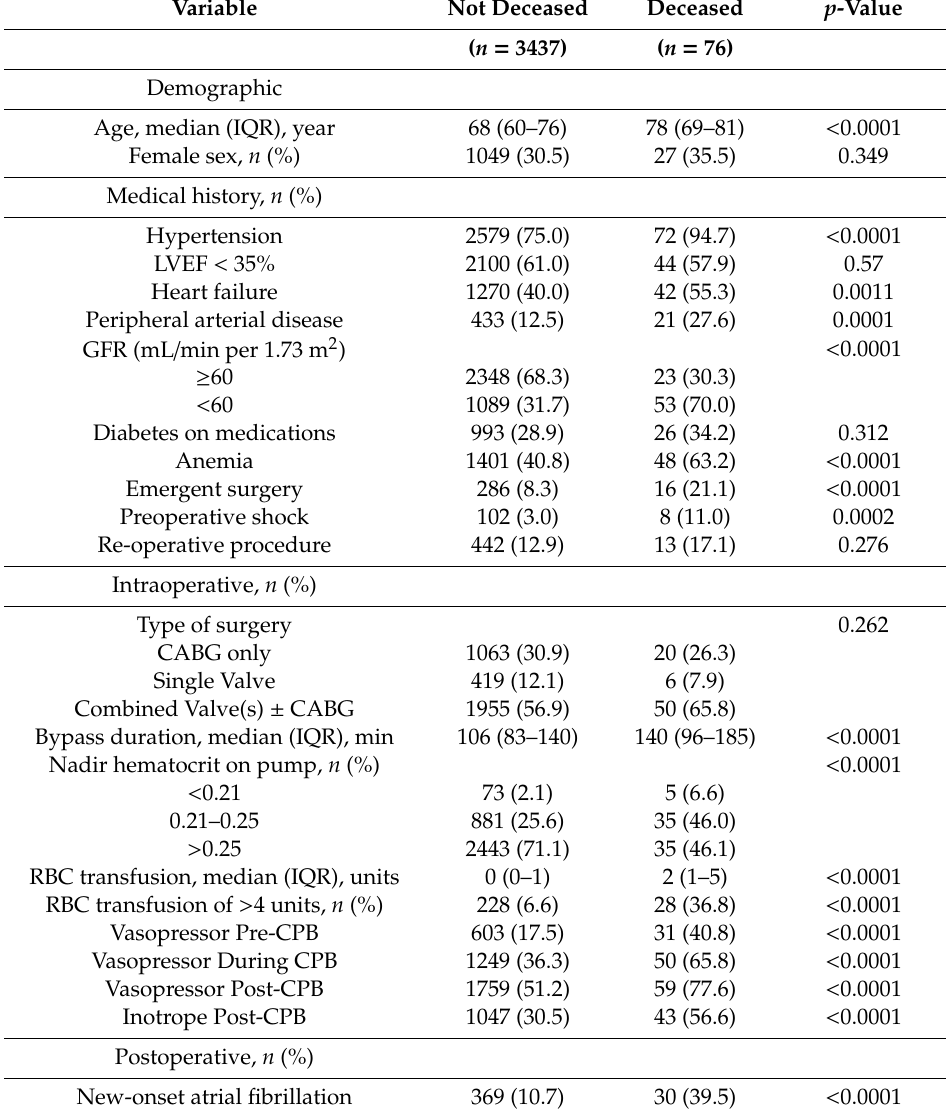
Table 1. Baseline and perioperative characteristics of intermediate-risk patients, as defined by a Cardiac Anesthesia Risk Evaluation (CARE) score of